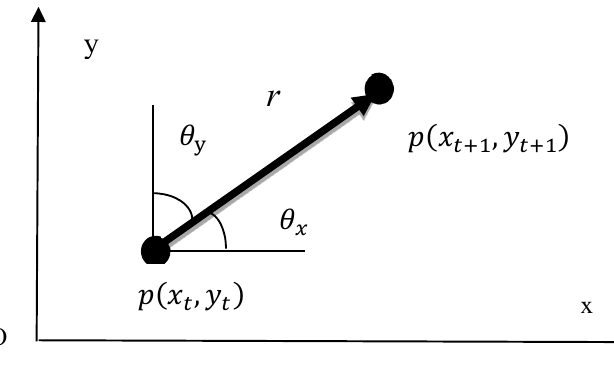
Figure 6. Diagram of motion vectors.